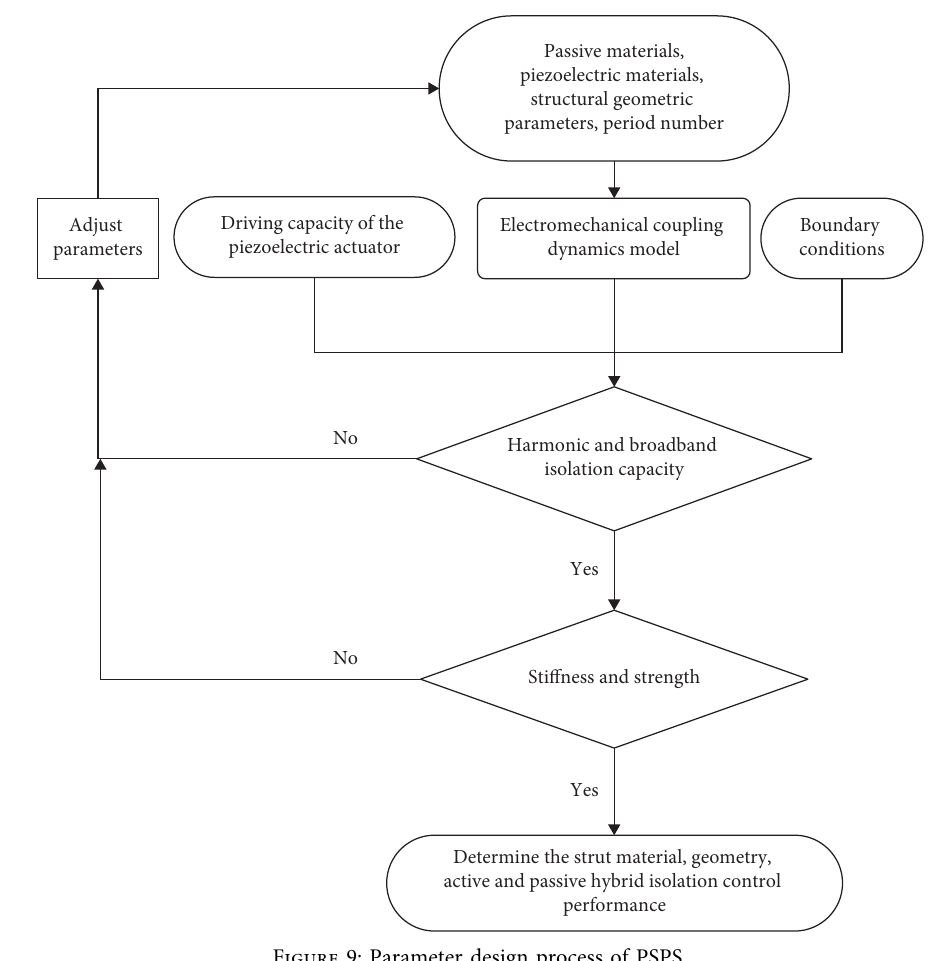
Figure 9: Parameter design process of PSPS.